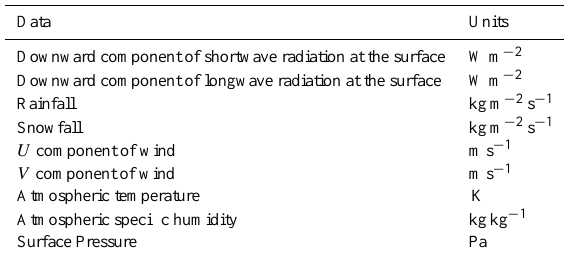
Table 1. Meteorological forcing data required to drive the JULES